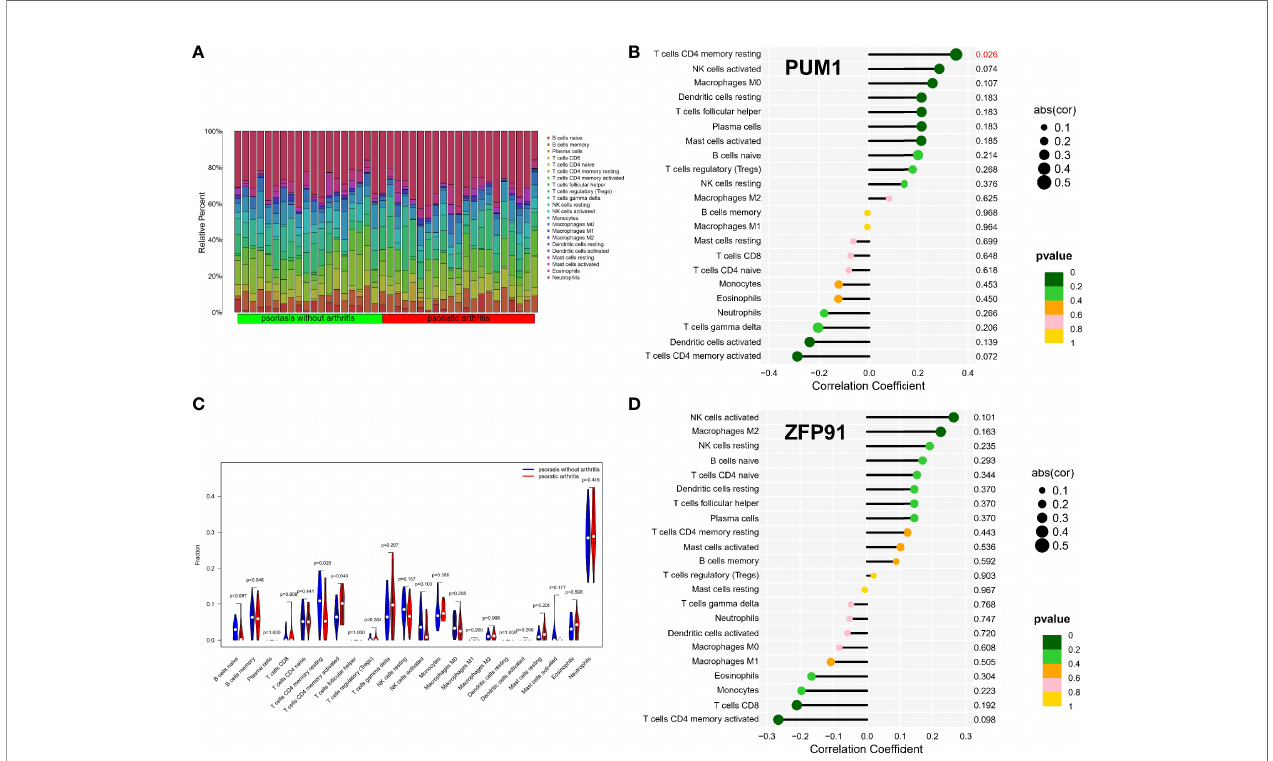
FIGURE 8 | Immune in fi ltration analysis of shared biomarkers in PsA . (A) The barplot of immune cell in fi ltration. (B) Correlation between PUM1 and in fi ltrating immune cells. (C) Violin diagram of the proportion of 22 types of immune cells. The red marks represent the difference in in fi ltration between the two groups of samples. (D) Correlation between ZFP91 and in fi ltrating immune